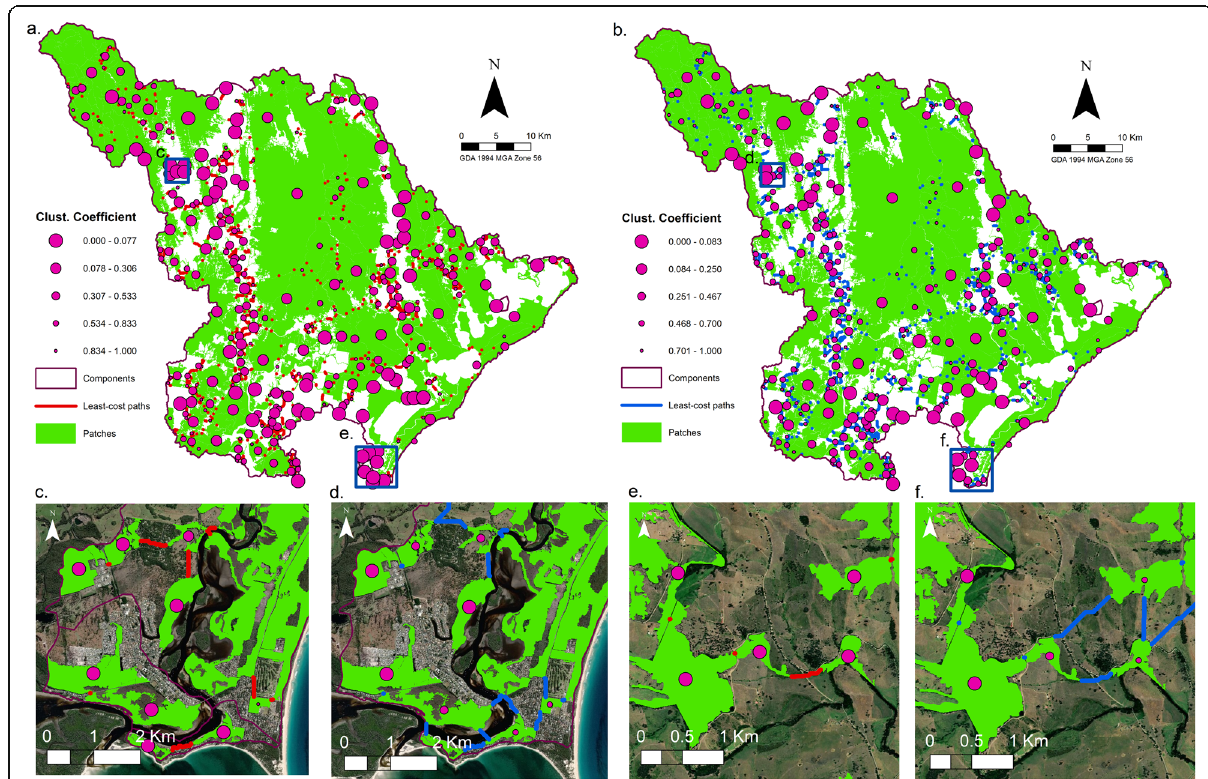
Fig. 5 Patch-scale metric, clustering coefficient (CC), characterises the level of redundancy (i.e. alternative routes) between neighbouring patches: a , c , e with the gap crossing layer characterising movement between scattered trees and b , d , f without the gap crossing layer. Large circles represent crucial patches for connectivity. c – f Insets showing the characteristics of the least-cost